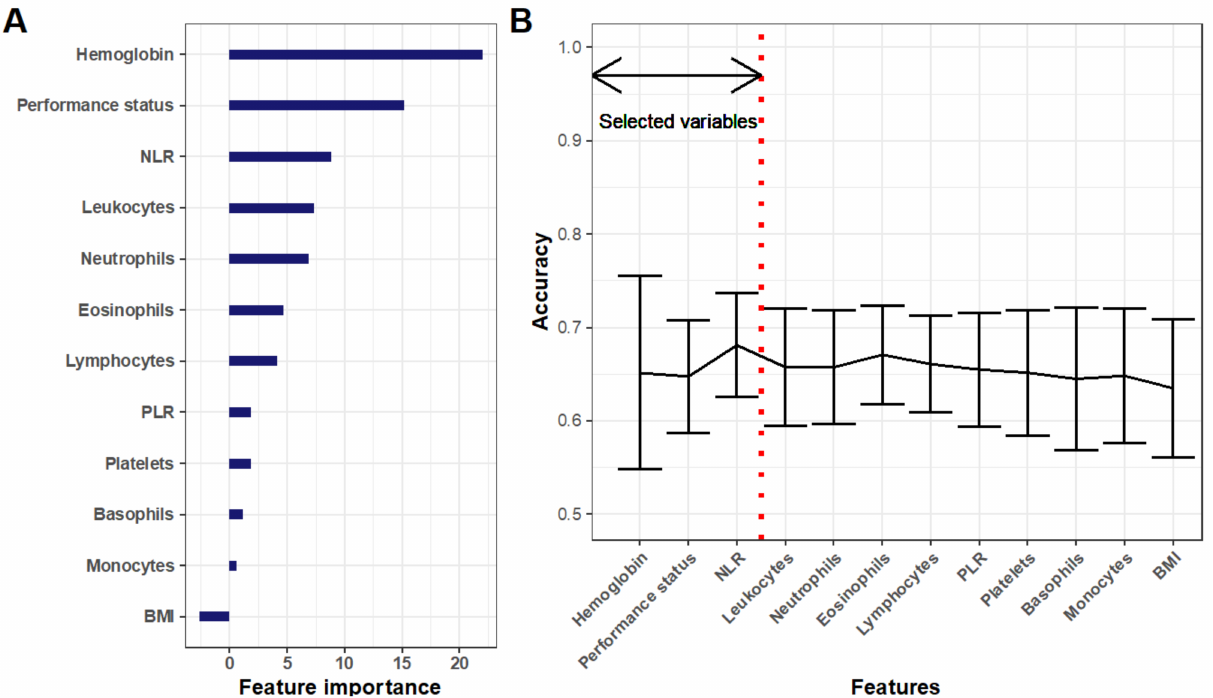
Figure 2. Variable selection. ( A ) Feature importance based on random forest classification and mean decrease in accuracy. ( B ) Accuracy score of incremental logistic regression models built on an increasing number of predictors (i.e., the first one contains only hemoglobin, the second hemoglobin and NLR, etc.). NLR = neutrophil-to-lymphocyte ratio. PLR = platelet-to- lymphocyte ratio. BMI = body mass